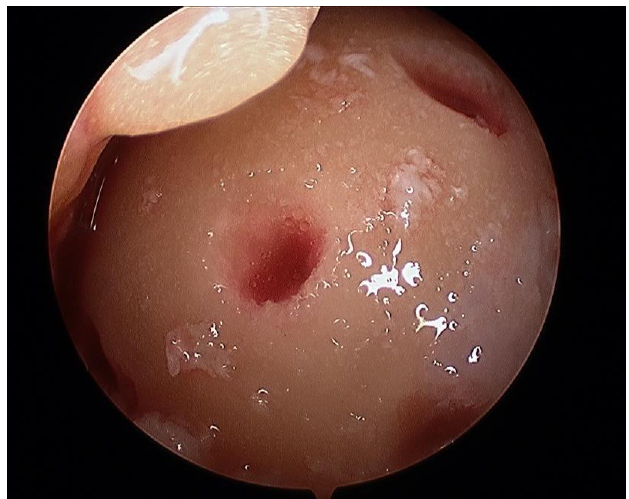
Figure 2. Microfractures in dry arthroscopy view prior to PRP injection.